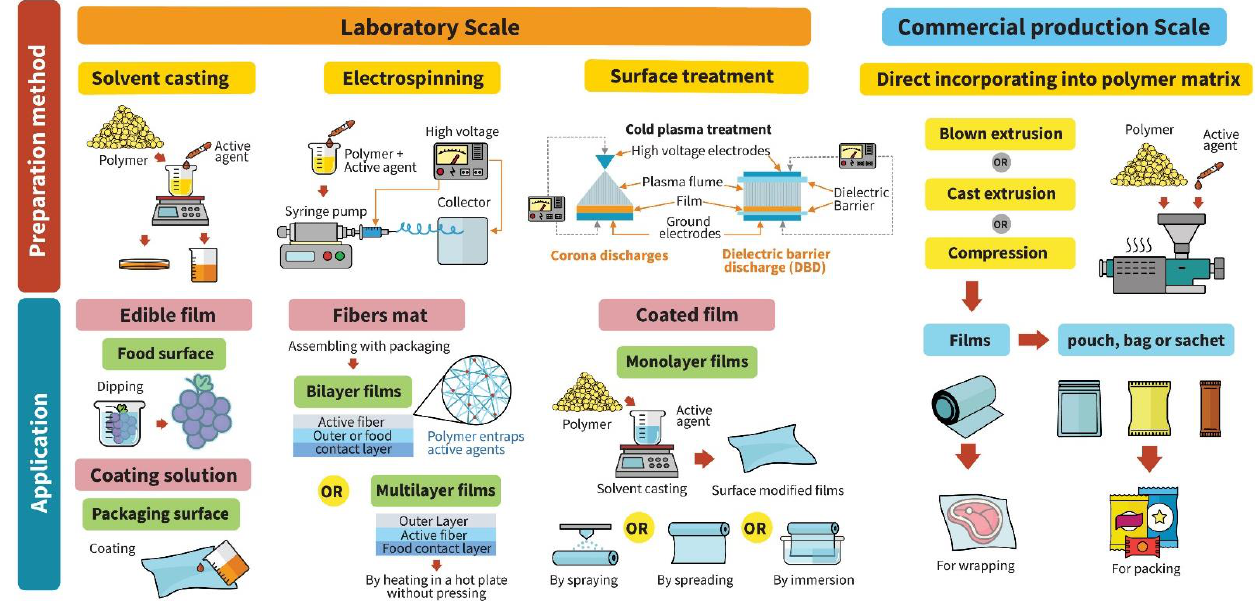
Figure 1. Different incorporation techniques used for developing antimicrobial packaging and their applications on food products.